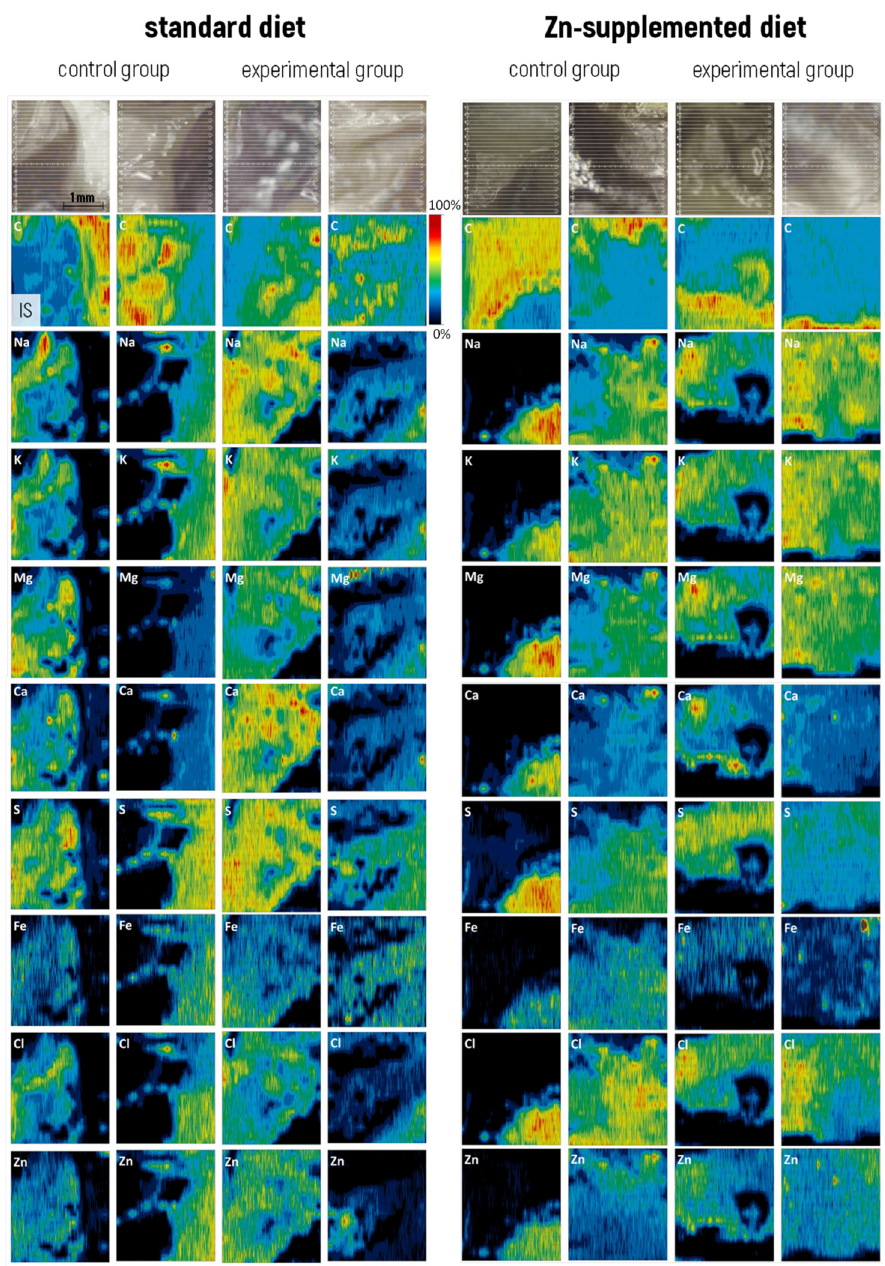
Figure 1. Elemental distribution maps of eight selected samples of the prostate gland, fed with two different diets and with (experimental) or without (control) implanted cancer cells. Each column represents the sample taken from the other animal (biological replicate). Relative signal intensities are normalized to the maximal signal for each sample and each element (100%).